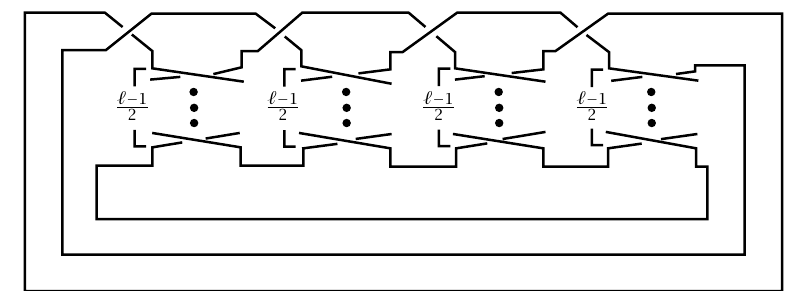
Figure 4.1 . The knot (cid:1) (cid:2)